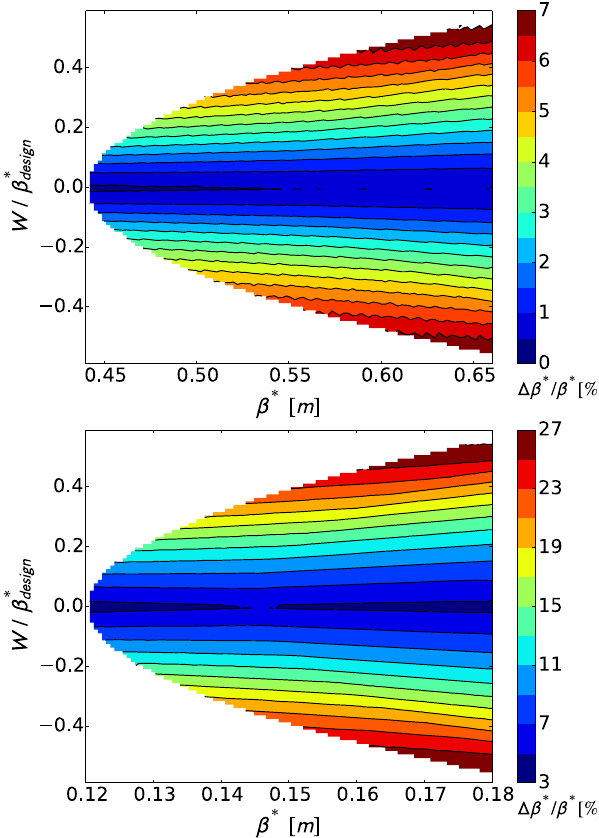
FIG. 5. Uncertainty Δ β (cid:1) = β (cid:1) for the LHC (top figure) and HL- LHC (bottom figure) over the relevant tune shifts. The minimum error occurs at χ ð 0 Þ for both the LHC and